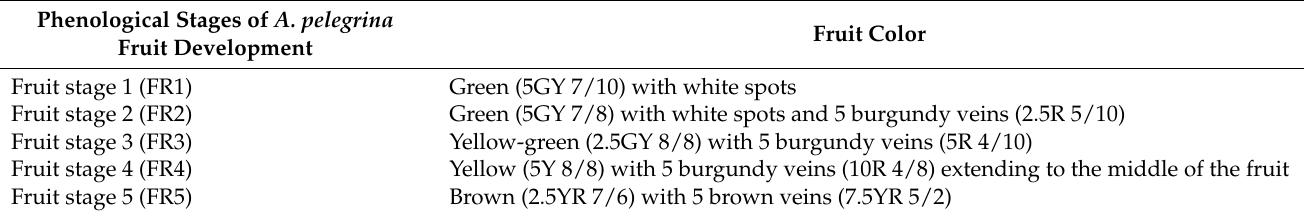
Figure 2. Morphological characterization of the distinct maturity stages of A. pelegrina fruit. FR1: Fruit stage 1; FR2: Fruit stage 2; FR3: Fruit stage 3; FR4: Fruit stage 4; FR5: Fruit stage 5. Scale bar: 5 mm. Table 2. Phenological stages of A. pelegrina fruit development and their respective coloration patterns.